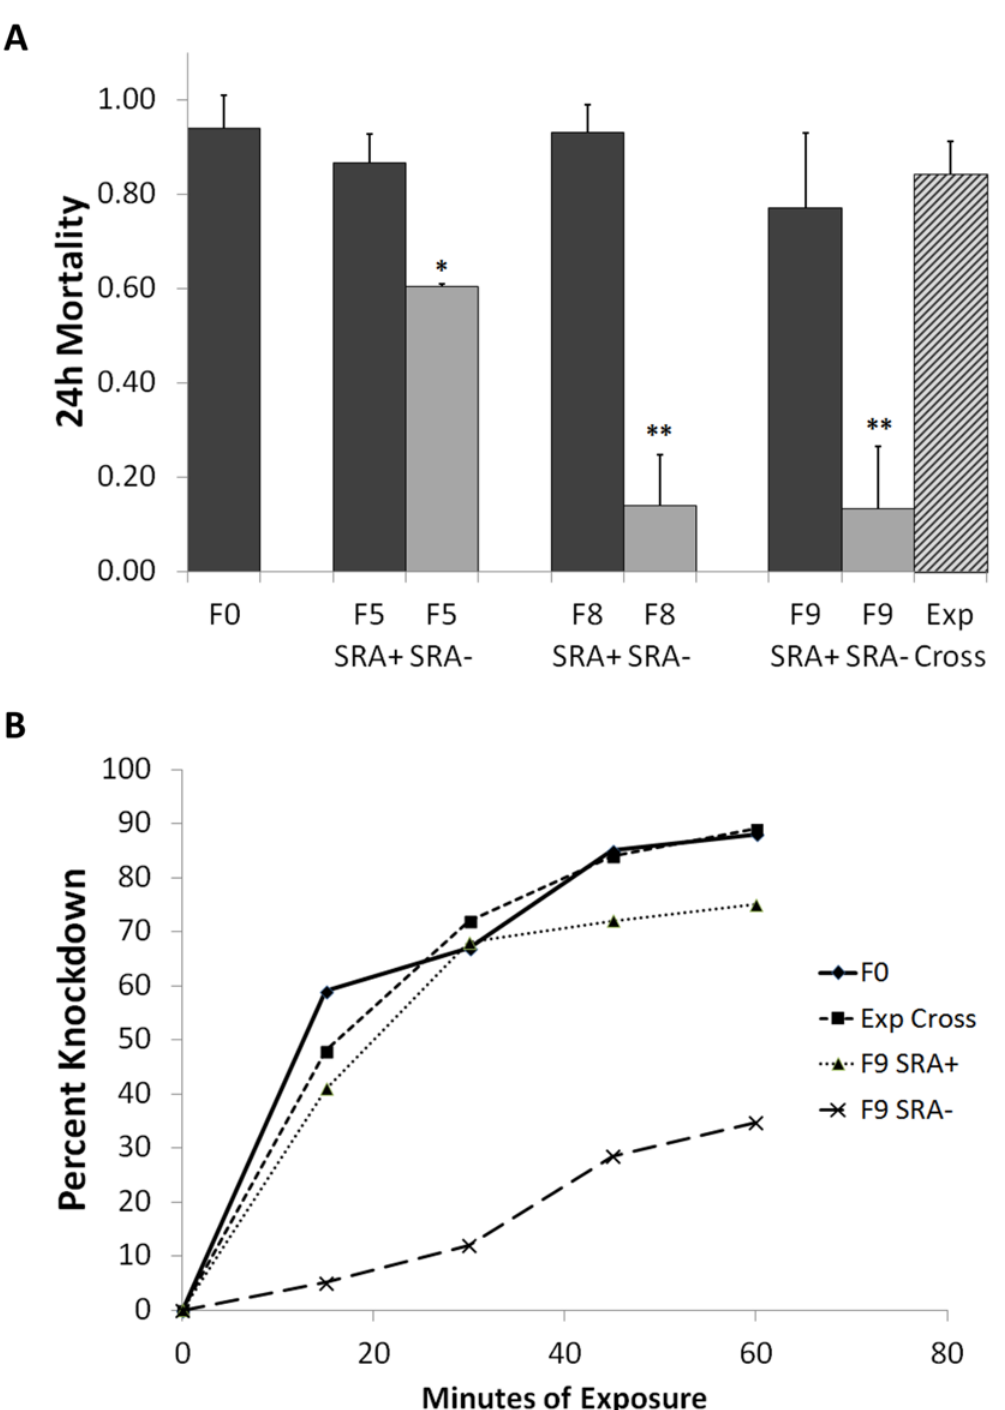
Fig 4. CDC bottle assay insecticide susceptibility patterns in selectively bred mosquito strains. (A) 24h mortality rates across various strains, asterisks signify significant differences from the baseline mortality rate * = P < 0.05, ** = P < 0.01. (B) Time to knockdown in a control (F1 unselected) strain and the F 9 generation of SR responders (SRA+) and non-responders (SRA-) and the experimental cross (F 8 SRA- females X F 1 wt males).